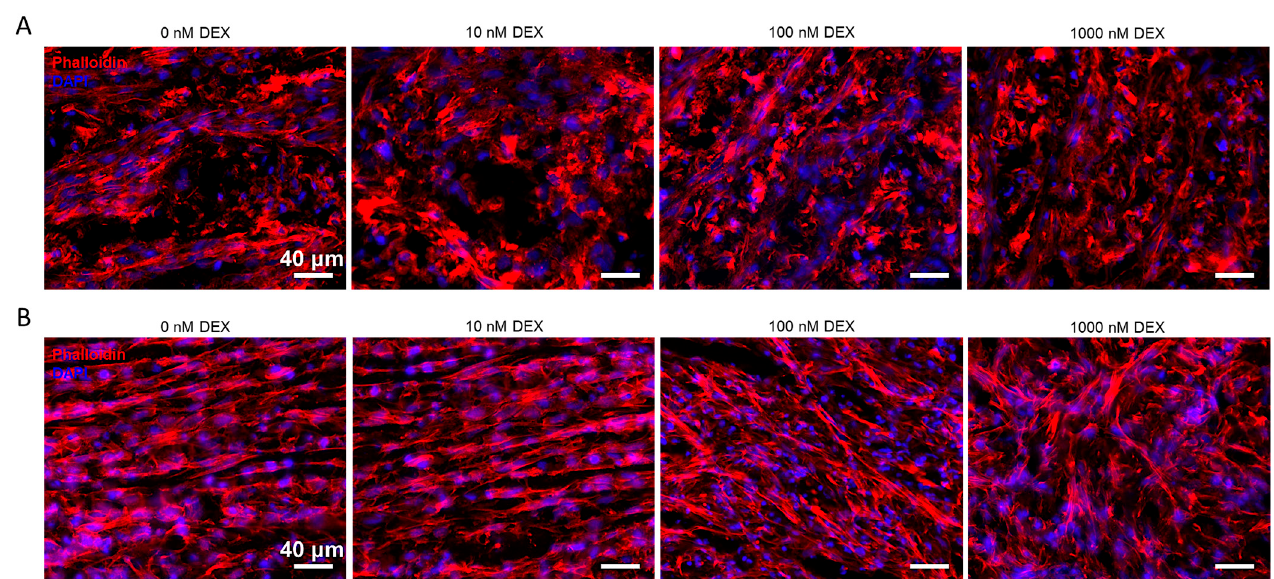
Figure 4. Representative fluorescent images of phalloidin- and DAPI-stained organoids at d1 ( A ) and d14 ( B ) of 3D maturation. Cell nuclei appear in blue, while F-actin in red.